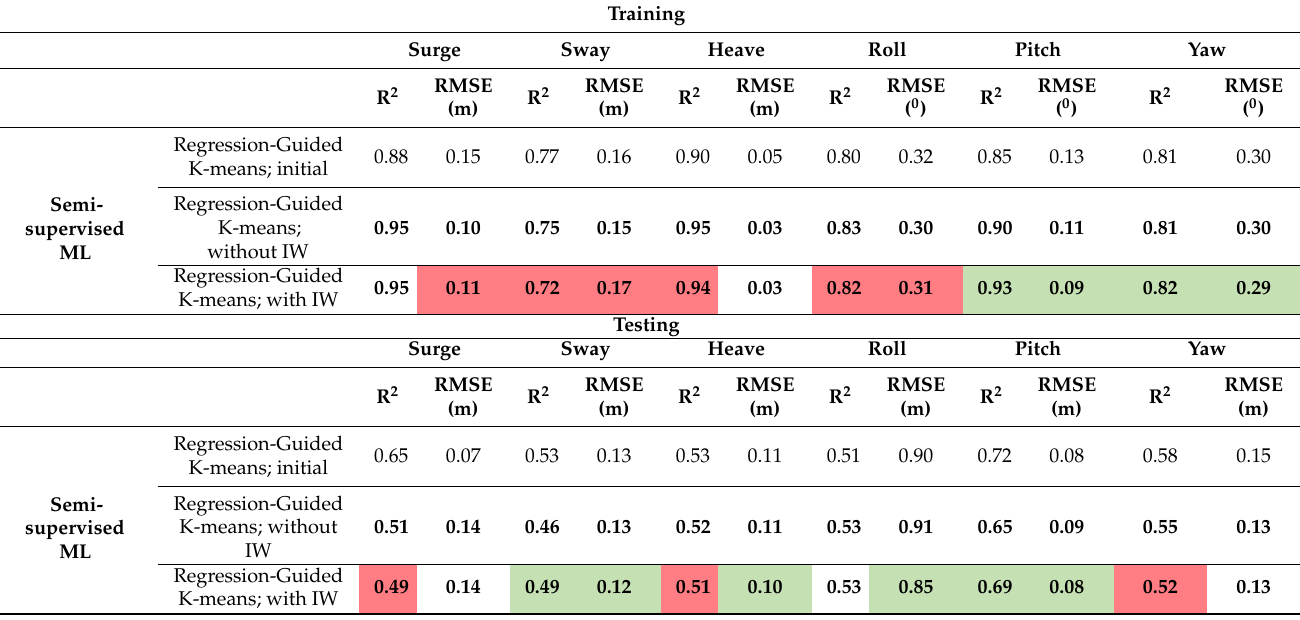
Table 7. Evaluation of the influence of infragravity wave parameters introduced as predictor variables in the model. Quantification of error, RMSE, and correlation, R 2 , of predictions of the 6 DoF of moored ship motions. Comparison between semi-supervised ML-based models with and without IW; in green, improvement, and in red,